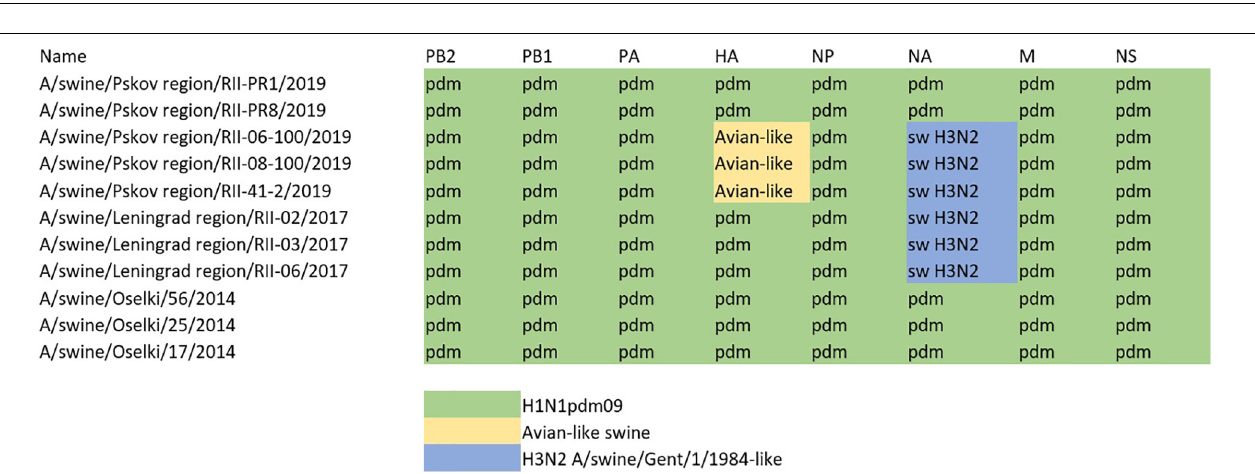
FIGURE 5 | Genomic constellation of internal genes of swine influenza A(H1) viruses described within the study.